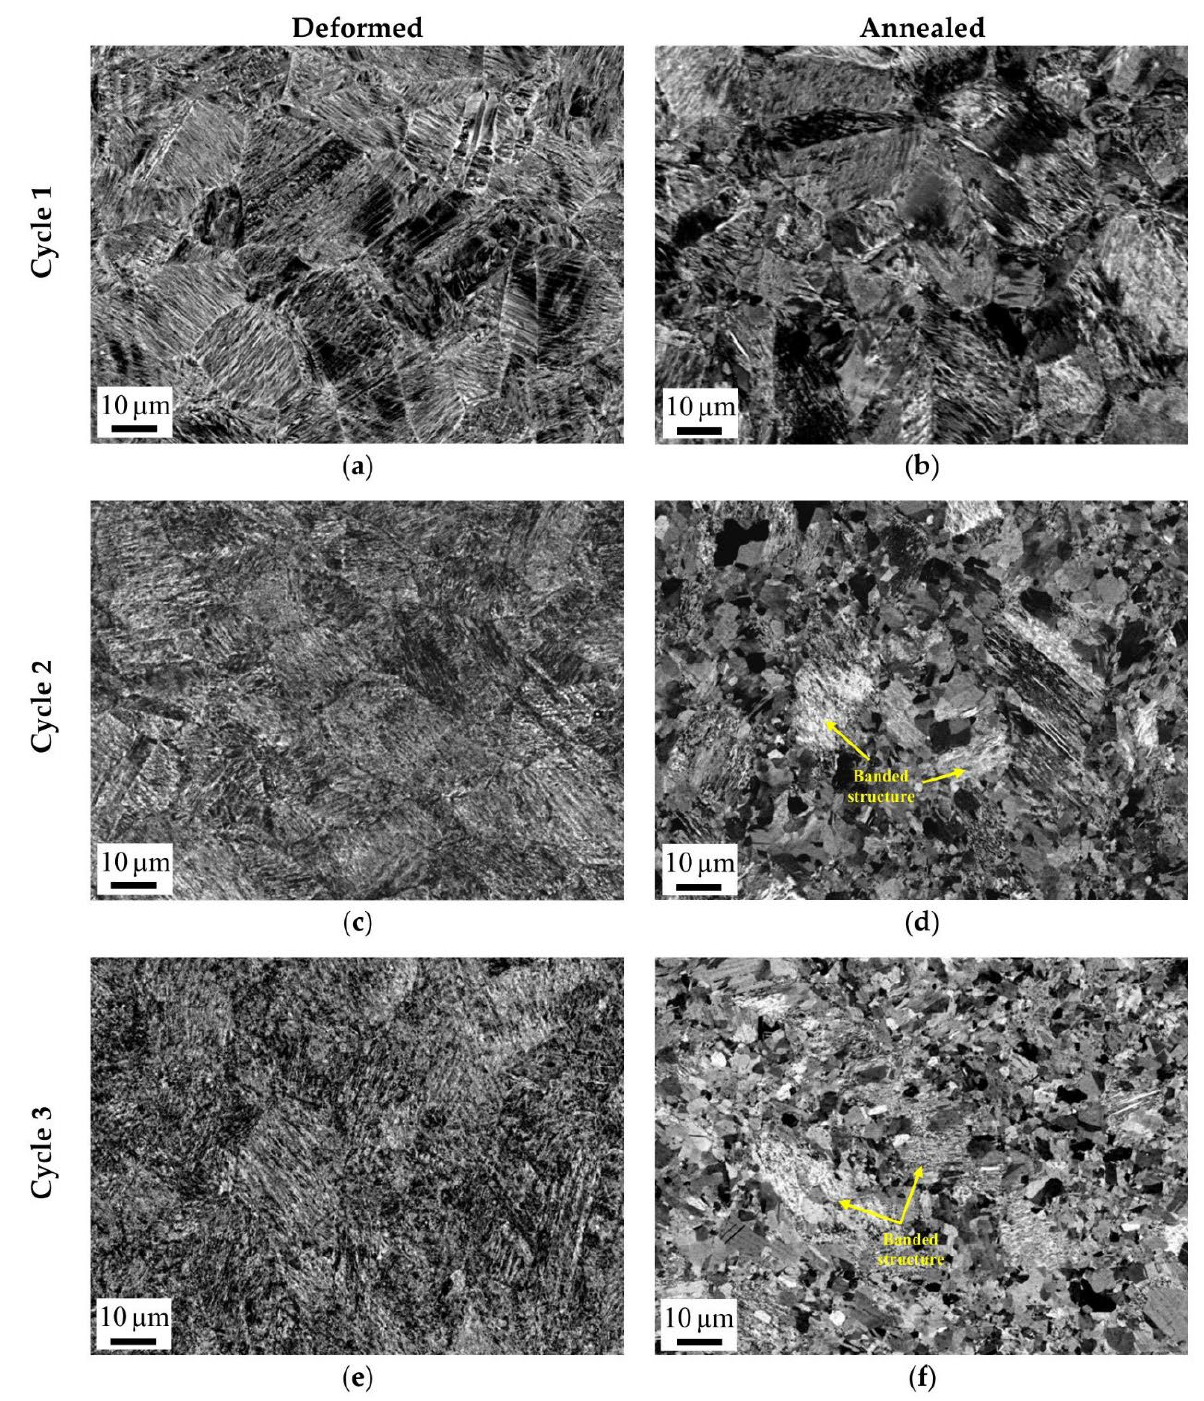
Figure 8. SEM micrographs of TMP samples processed using three cycles and strain of 0.15: ( a , b ) Cycle 1, ( c , d ) Cycle 2, and ( e , f ) Cycle 3.